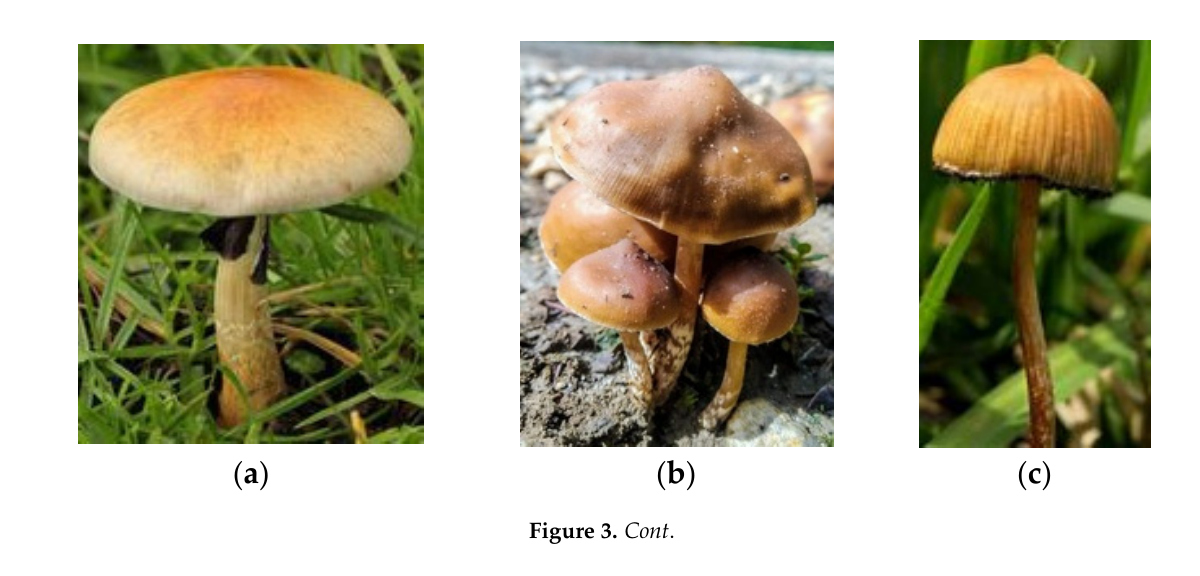
( k ) Figure 3. Examples of Magic mushrooms (psilocybin-producing mushrooms). ( a ) Psilocybe cubensis (Earle) Singer a.k.a Stropharia cubensis [131]. ( b ) Psilocybe caerulescens Murrill (a.k.a. Landslide Mushrooms, Derrumbes) [132]. ( c ) Psilocybe mexicana R. Heim (a.k.a. Teonanacatl, Pajaritos) [133]. ( d ) Psilocybe caerulipes (Peck) Sacc. (a.k.a Blue Foot Mushroom) [134]. ( e ) Psilocybe stuntzii Guzmán and J. Ott (a.k.a. Blue Ringer Mushroom, Stuntz’s Blue Legs) [135]. ( f ) Psilocybe cyanescens Wakef. (a.k.a. Wavy Caps) [136]. ( g ) Psilocybe azurescens Stamets and Gartz (a.k.a Flying Saucer Mushrooms)’ [137]. ( h ) Psilocybe pelliculosa (A.H. Sm.) Singer and A.H. Sm. [138]. ( i ) Psilocybe tampanensis Guzmán and Pollock (a.k.a Magic Truf- fles, Philosopher’s Stone [139]. ( j ) Psilocybe baeocystis Singer and A.H. Sm. [140]. ( k ) Psilocybe Hoogshagenii R. Heim nom. inval . (a.k.a. Little Birds of the Woods) [141] .